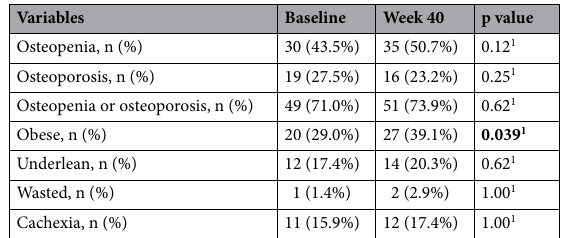
Table 5. Prevalence of osteopenia and osteoporosis and underlean, obese, cachexia, and wasted during the study. 1 McNemar’s test. p values marked in bold represent significant